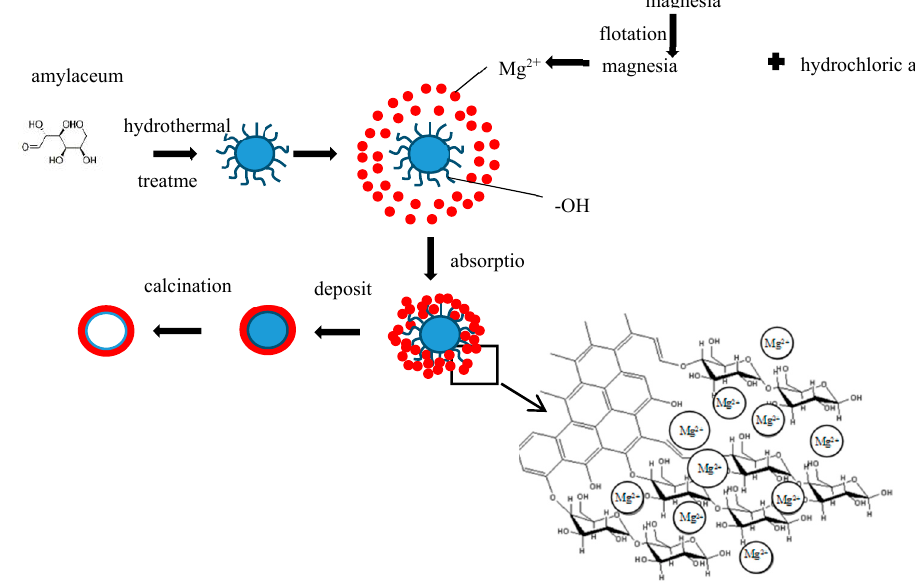
Figure 1. Schematic illustration of the preparation of hollow MgO microspheres.